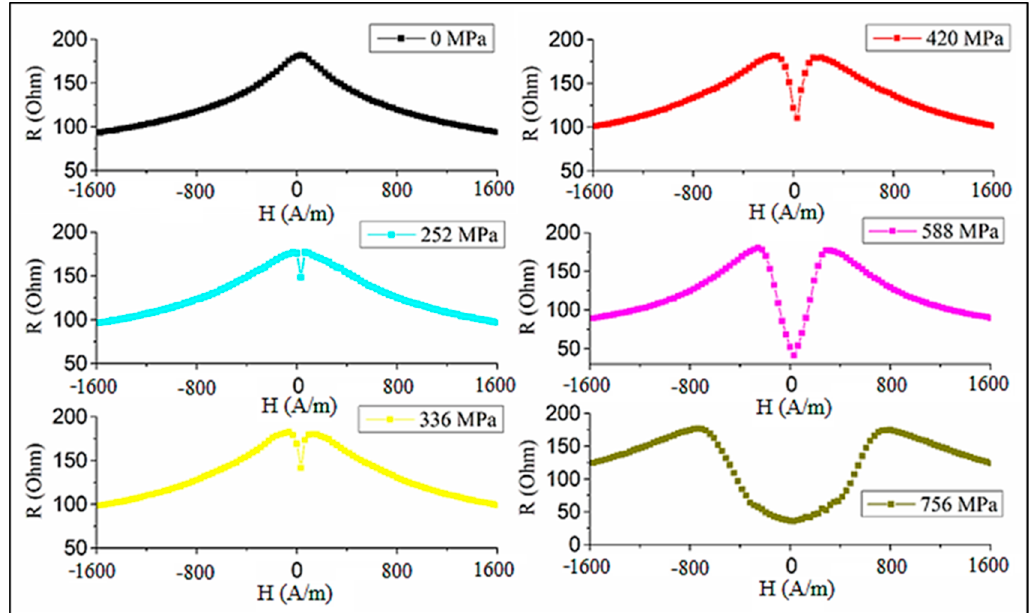
Figure 16. Effect of tensile stress on magnetoimpedance in as-prepared amorphous Co 71 Fe 5 B 11 Si 10 Cr 3 microwires. Real part of the impedance 𝑅(𝐻) is given. Frequency is 50 MHz.